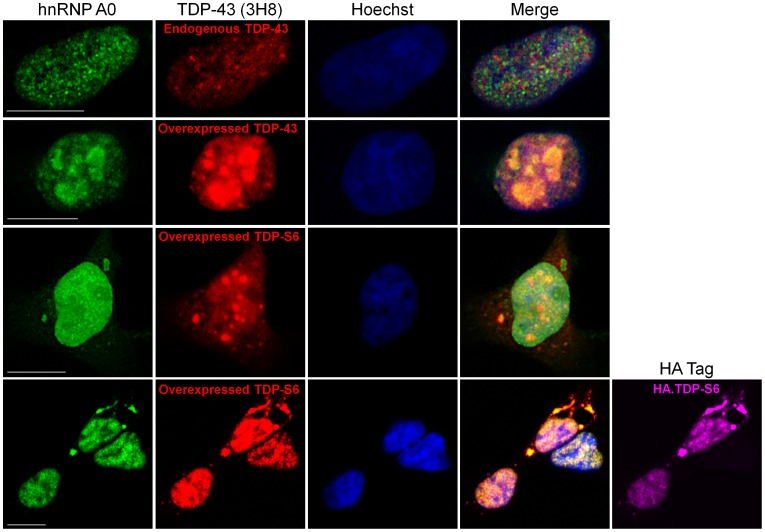
hnRNP A0 colocalization in inclusion bodies positive for overexpressed TDP-43 and TDP-S6 in HEK-293 cells.Endogenous or overexpressed TDP-43 or TDP-S6 (red) localization relative to endogenous hnRNP A0 (green). In the lower set of images, triple staining was performed to differentiate overexpressed TDP-S6 from endogenous TDP-43 in a neighboring cell; HA staining not included in the merged image is shown in magenta. Nuclei are stained with Hoechst dye (blue). Scale bars, 10 µm.